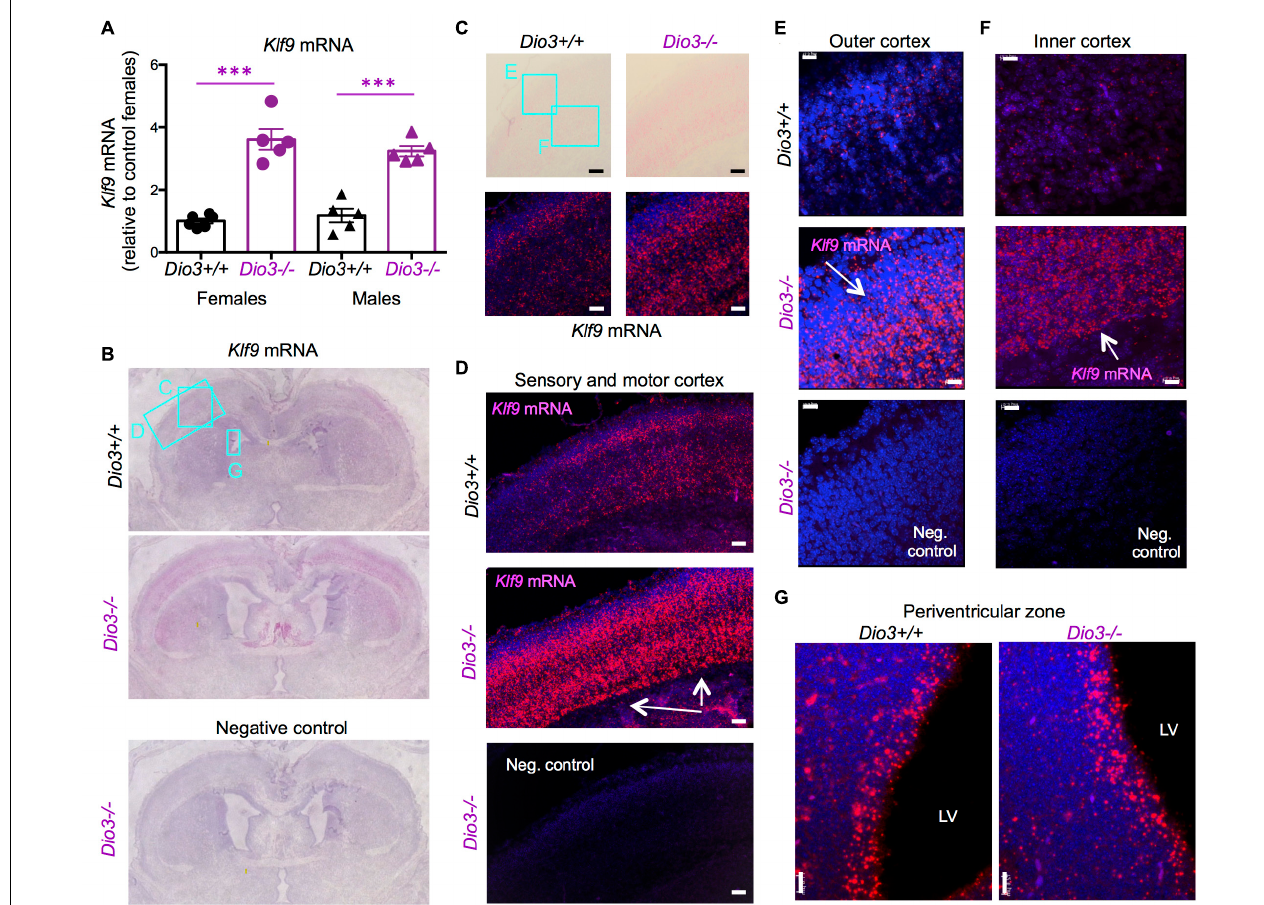
FIGURE 2 | Klf9 expression is elevated in Dio3 − / − brains. (A) Klf9 mRNA expression in whole E18.5 brains. Data represent the mean ± SEM of 11 and 10 different samples from E18.5 Dio3 + / + and Dio3 − / − mice, respectively, divided by sex. ∗∗∗ p < 0.001 E13.5 vs E18.5 as determined by the ANOVA and Tukey’s post hoc test. B-G, Bright field and fluorescent images of in situ hydridization of Klf9 mRNA in whole brain coronal sections (B) , motor cortex (C) , motor and sensory cortex (D) , outer and inner cortical layers [ (E,F) , respectively] and lateral periventricular zone (G) . Images are representative of two different animals of each genotype. Rectangles and letters indicate the panels in which those anatomic regions are amplified. St, striatum; Lv, lateral ventricle. Negative control was hybridized with a bacterial probe. Arrows indicate major areas of differential expression. Scale bars, 45, 15, and 12 microns for panels (C – G) ,